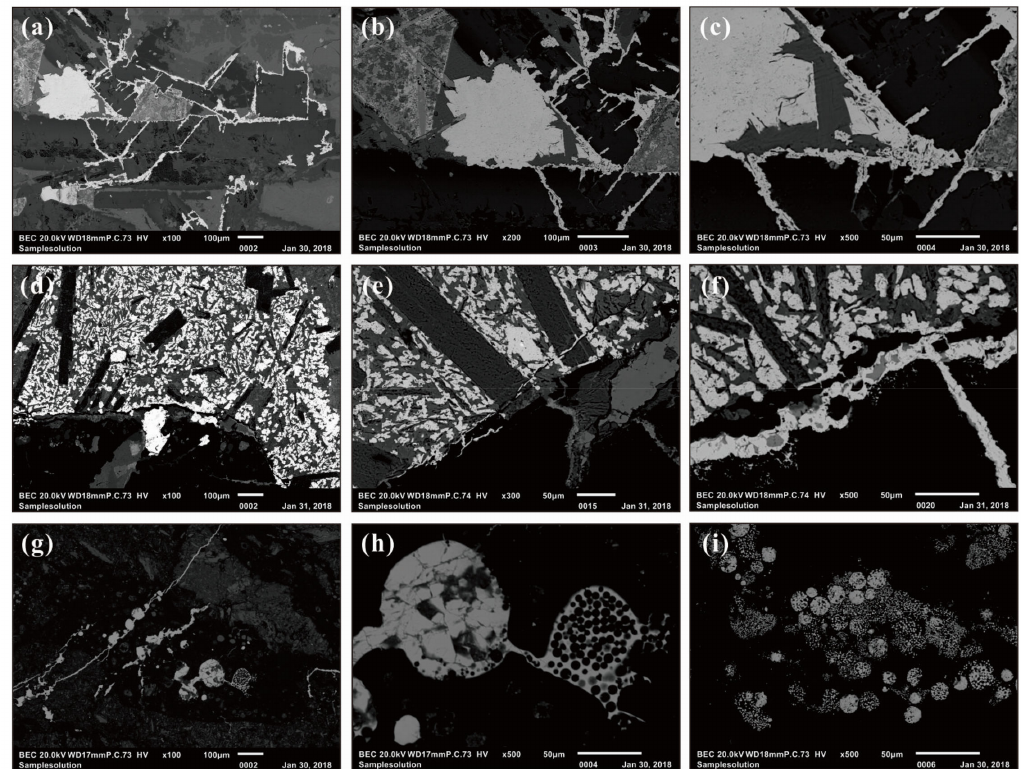
Figure 3. Back scattered electron image of pyrites from the Yuandian Coal Mine: ( a ) coarse-grained subhedral pyrites and thin pyrite veinlets around plagioclase in diabase (Y1-05R, 100 × ); ( b ) pyrite veinlets in the fractures of plagioclase (Y1-05R, 200 × ); ( c ) straight edge of coarse-grained pyrites (Y1-05R, 500 × ); ( d ) fine-grained pyrites around feldspar in metamorphic aureole (Y1-04A, 100 × ); ( e ) densely-disseminated pyrites in the groundmass at the diabase chilled margin (Y1-04A, 200 × ); ( f ) pyrites encircle and crosscut mesocarbon microbeads in metamorphic aureole (Y1-04A, 500 × ); ( g ) fine pyrite veinlets and spherical pyrite aggregates in cokeite (Y1-03C, 100 × ); ( h ) pyrites fill in pores and encapsulate mesocarbon microbeads in cokeite (Y1-03C, 500 × ); ( i ) disseminated pyrites and framboidal pyrites in unaffected coal (Y1-18S, 500 ×